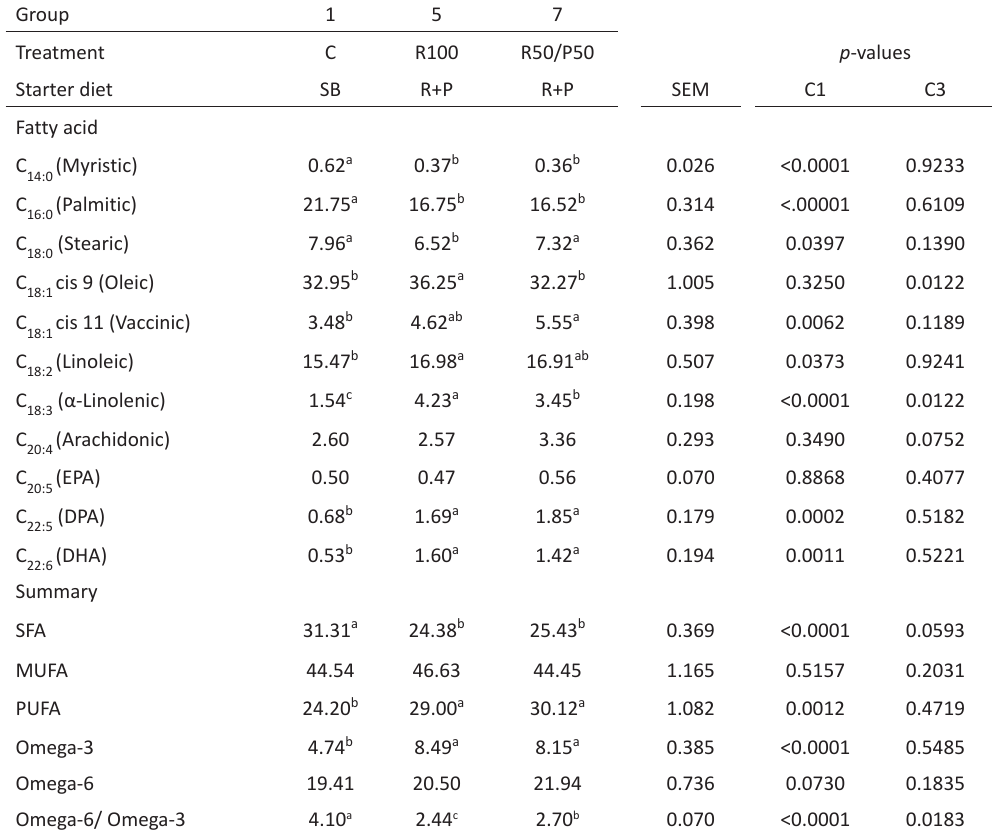
Table 10. Mean fatty acid composition of broiler breast meat lipids in response to diets with soybean meal (SB), rapeseed meal (R), or rapeseed meal and peas (P) Group 1 5